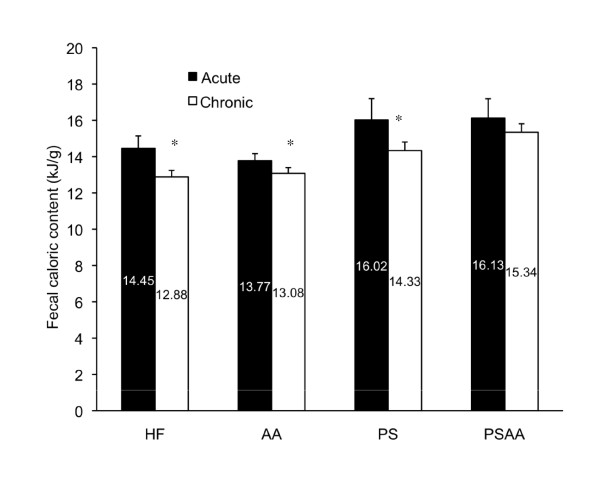
Fecal caloric content in age-matched animals exposed to the diet for 72 hours (acute - closed bars) or 17 weeks (chronic - open bars). A significant decline in caloric content of the feces was observed in animals chronically exposed to the diet in the HF, AA and PS groups when compared to an acute 72-hour exposure in age-matched individuals (n = 7; t-test within each dietary group). Asterisks indicate a significant decline in fecal caloric content is observed in animals exposed to a diet for 17 weeks when compared to acute dietary exposure. After caloric content was corrected for estimated phytosterol content, no significant difference was observed between the diets within each exposure.